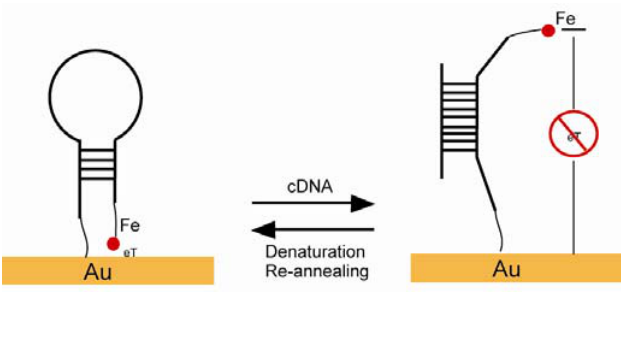
Figure 14. A stem-loop structure with a terminal ferrocene tag. The hybridization of target DNA changed the stem-loop structure and the electron transfer stopped, hence, the corresponding cyclic voltammogram changed (adapted from